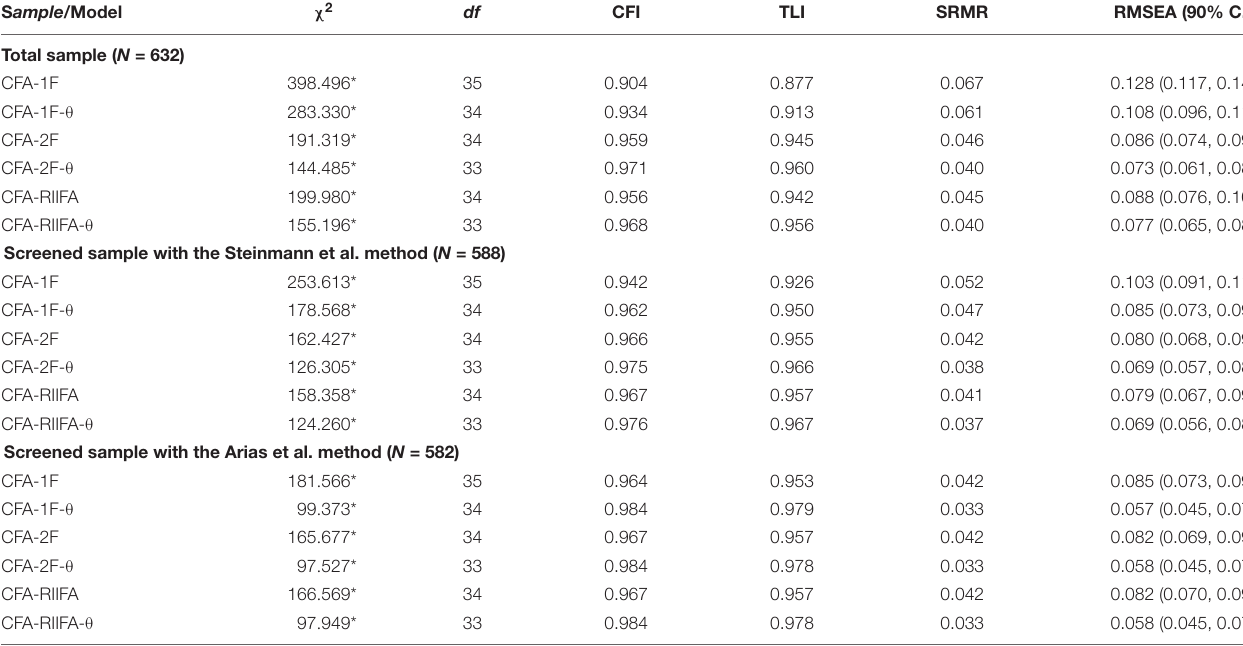
TABLE 2 | Fit statistics for the RSES factorial